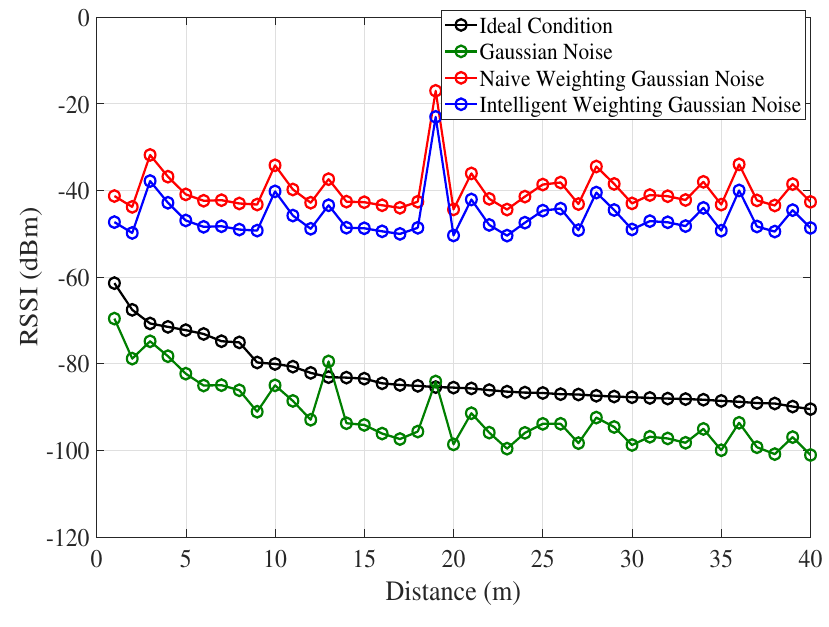
Figure 5. Distance vs.